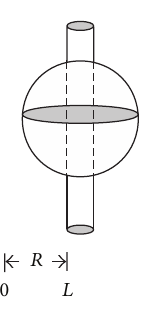
Figure 3: Graphical representation of a spherical